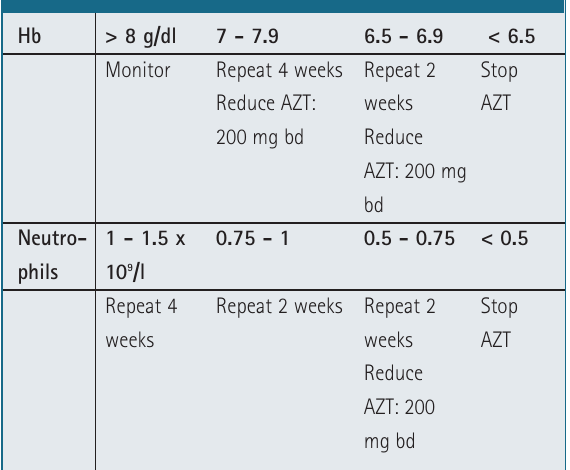
TABLE IX. GUIDELINES FOR MANAGING HAEMATOLOGICAL TOXICITY (MAINLY ZIDOVUDINE- INDUCED)